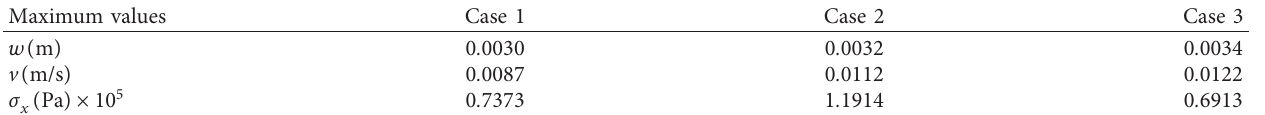
Table 4: Maximum deflections, velocities, and stress at the central point of the plate versus time. Maximum values Case 1 Case 2 Case